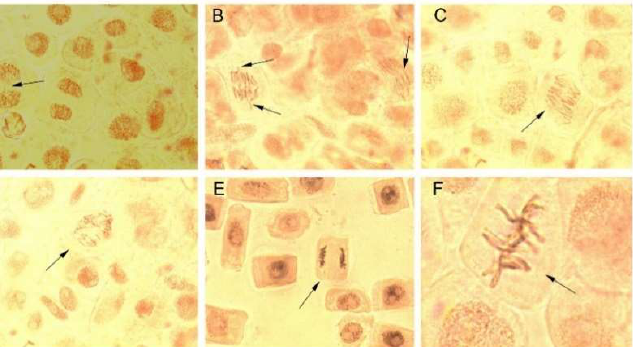
Figure 9. Chromosomal aberrations ( A–C ) and normal stages of mitotic division ( D–F ) in Allium cepa root meristems exposed to Picea abies and Pinus nigra bark extracts and their derived AgNPs. ( A ) telophase with two interrupted bridges (exposure to Picea abies bark extract); ( B ) incipient anaphase-telophases with vagrant chromosomes and multiple bridges (exposure to Picea abies bark extract derived AgNPs); ( C ) incipient anaphase-telophases with multiple bridges (exposure to Pinus nigra bark extract derived AgNPs); ( D ) normal pro-metaphase (control); ( E ) normal anaphase (control); ( F ) normal metaphase (control).